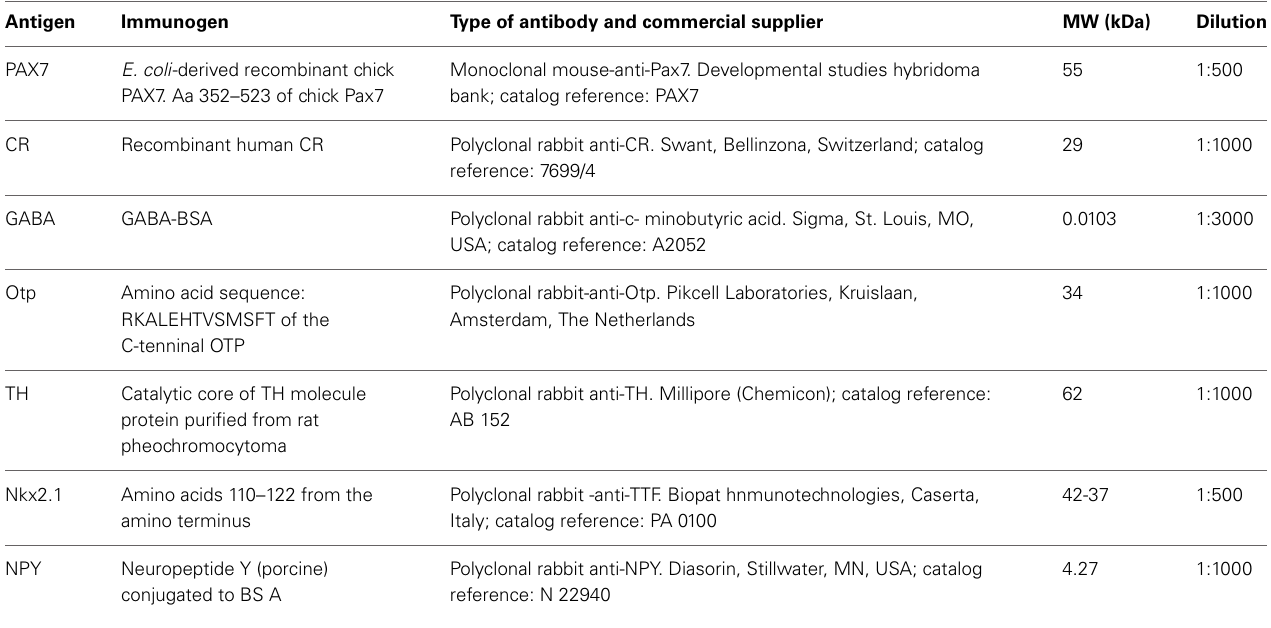
Table 2 | Antibodies used in the present